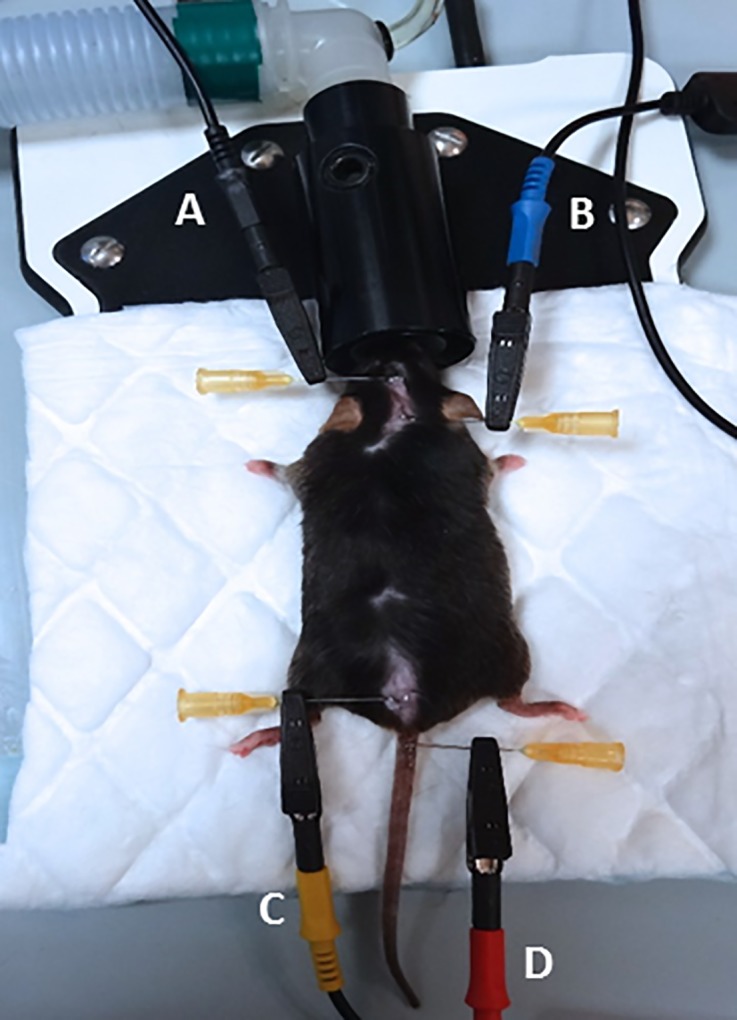
Placement of bioimpedance spectroscopy electrodes on a mouse.Four 25G needles are placed subcutaneously along the midline of the back and serve to connect the electrodes to the animal. The B electrode (blue) is placed at the intersection between the median line and the line between the ears. The A electrode (black) is placed 1 cm from B towards the muzzle. The C electrode (yellow) is placed between the median line and that joining the thigh muscles. The D electrode (red) is placed 1 cm backwards at the base of the tail. The length between B and C needle electrodes is measured; this parameter, as well as the age and weight of the animal, is required by the software to calculate the proportion of fat mass.